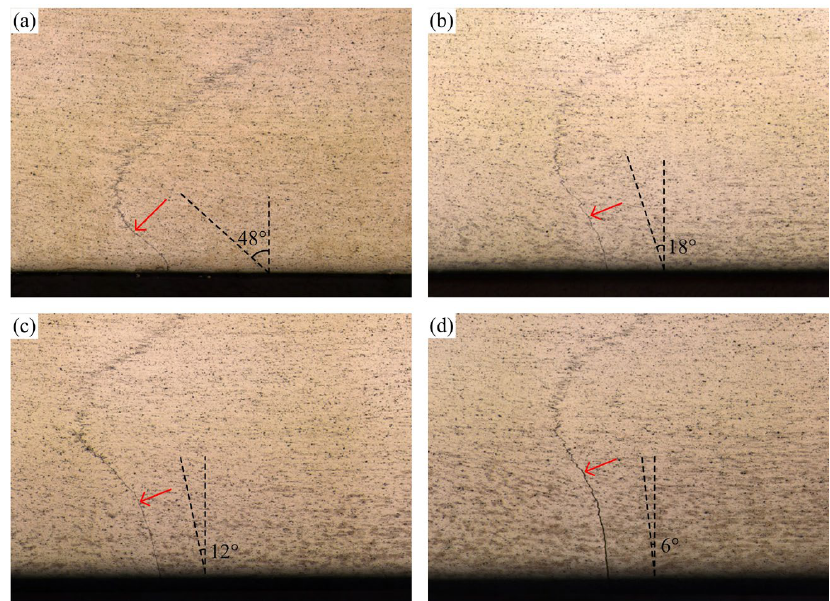
Figure 12. Magnified incomplete-penetration defects: ( a – d ) corresponding to the featured region A–D in Figure 11.